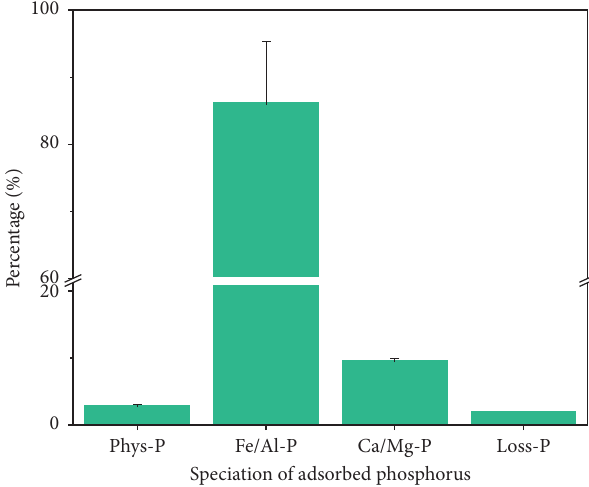
Figure 11: Speciation analysis of adsorbed phosphorus on ceramsite (pH � 7, t � 10min, adsorbent dosage � 2 g · L − 1 , 120rpm, initial phosphorus concentration � 10mg · L − 1 , and 25 ° C).